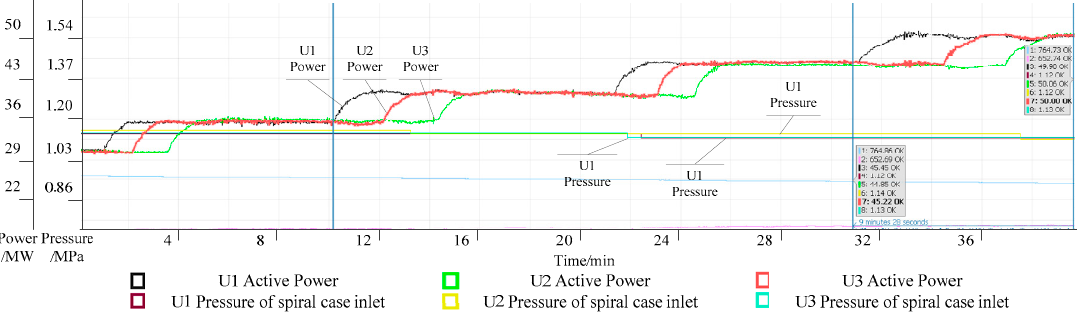
Figure 18. Field data of power regulating process.